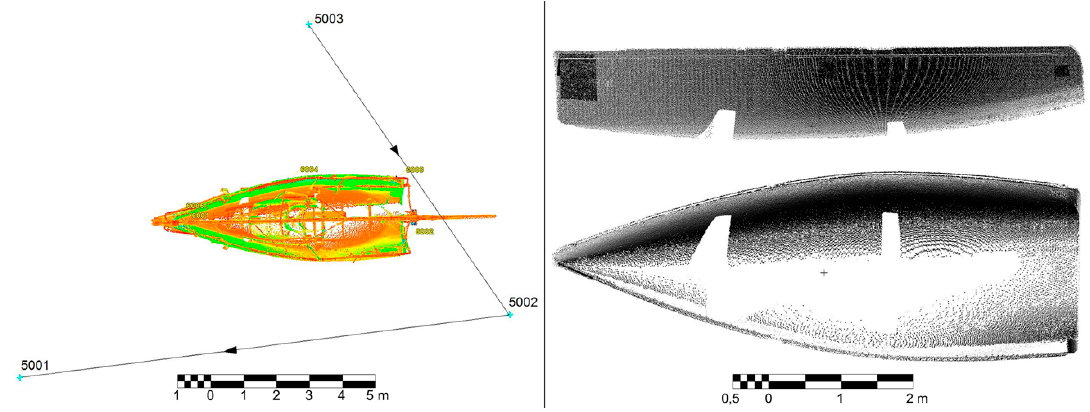
Figure 5. Left—positions of the laser scanner; right—the final point cloud.